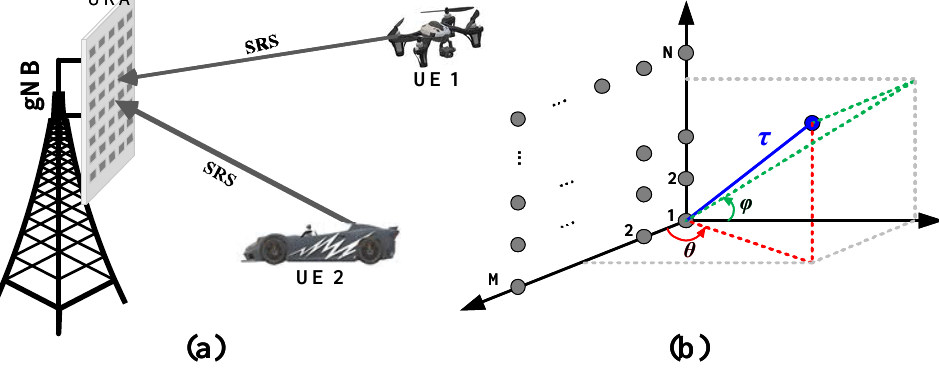
Figure 1. ( a ) System schematic diagram of the URA-based 5G NR 3D positioning; ( b ) URA geometry and dimension illus- tration. SRS, sounding reference